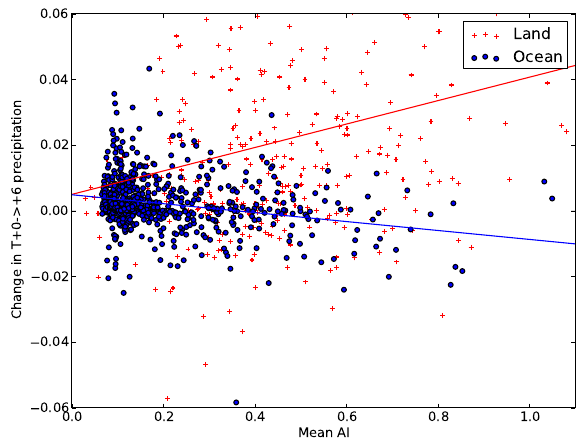
Figure 6. The dependence of the mean precipitation rate over the period T + 0 → + 6 on local mean AI for oceanic (blue dots) and continental (red crosses) shallow cumulus. The change in precip- itation points are taken from Fig. 4a. The straight lines are linear regressions over land (red) and ocean (blue)